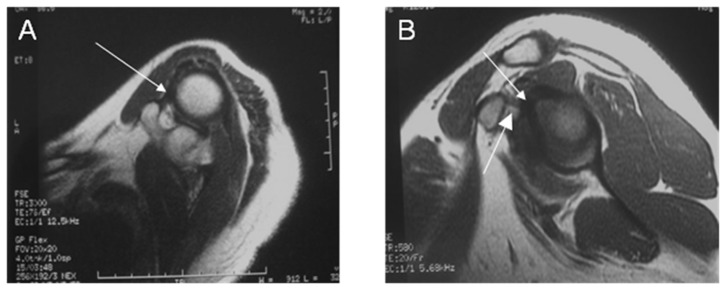
MR image shows thickened and slightly twisted CHL (arrow) in a 52-year-old patient with AC in axial plane T1WI (A) and in sagittal oblique plane (B).